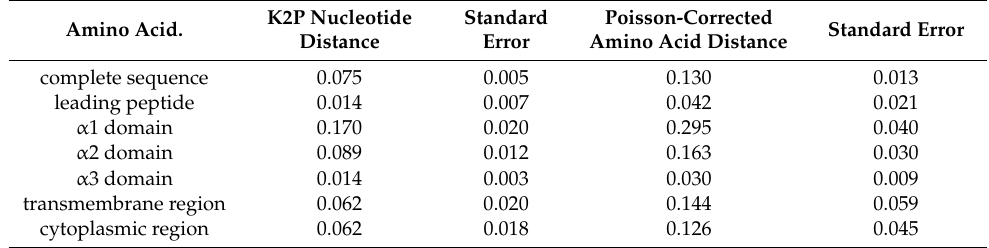
Table 2. Average nucleotide and amino acid distances among the 23 newly isolated alleles. Amino